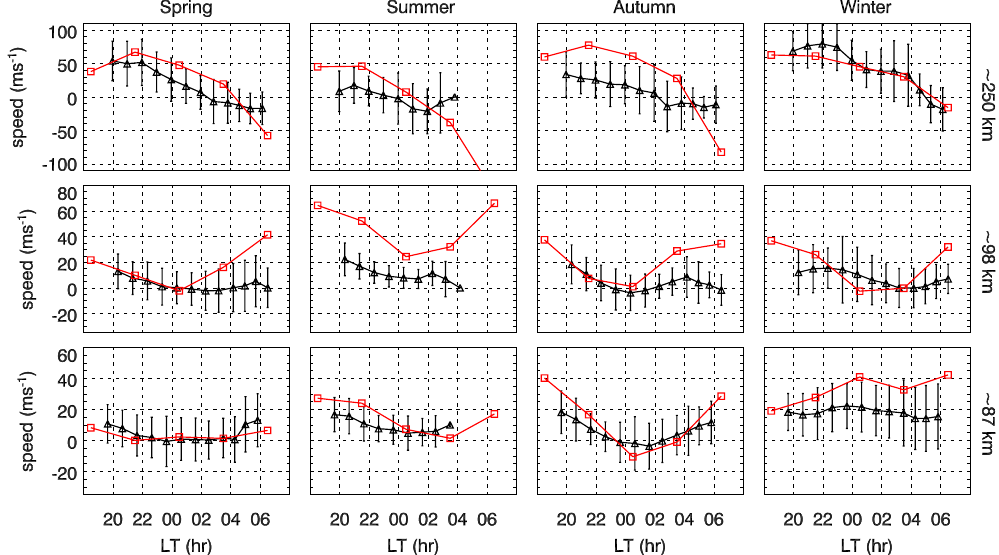
Fig. 6. Seasonally averaged nighttime zonal (eastward positive) wind from FPI (black triangle) and HWM07 (red square) in spring (first column), summer (second column), autumn (third column), and winter (fourth column) at the altitudes of ∼ 250km (first row), ∼ 98km (second row), and ∼ 87km (third row). The error bars are calculated from the standard deviation of the data points used for the seasonal average.